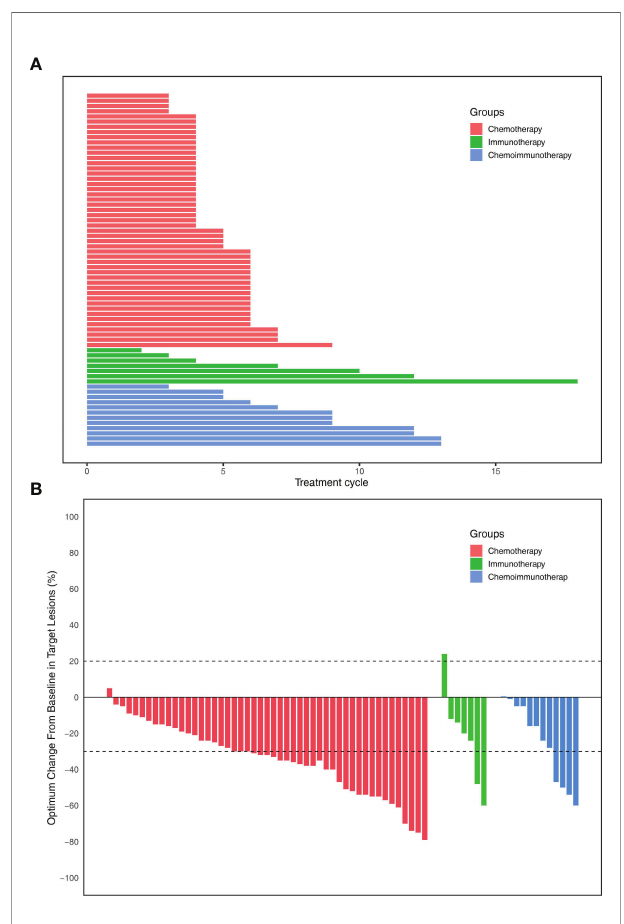
FIGURE 2 | (A) Total number of treatment cycles of each patients. (B) The optimum change in individual patients of three